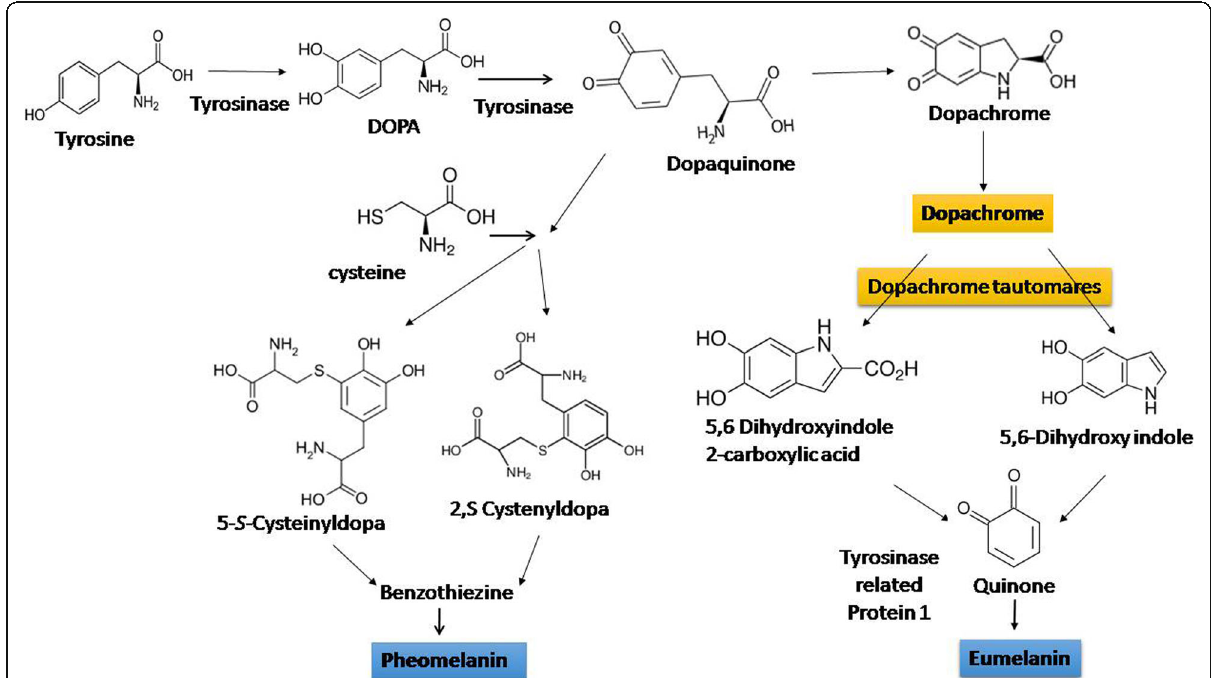
Fig. 3 Schematic representation of the melanin synthesis including pheomelanin and eumelanin in